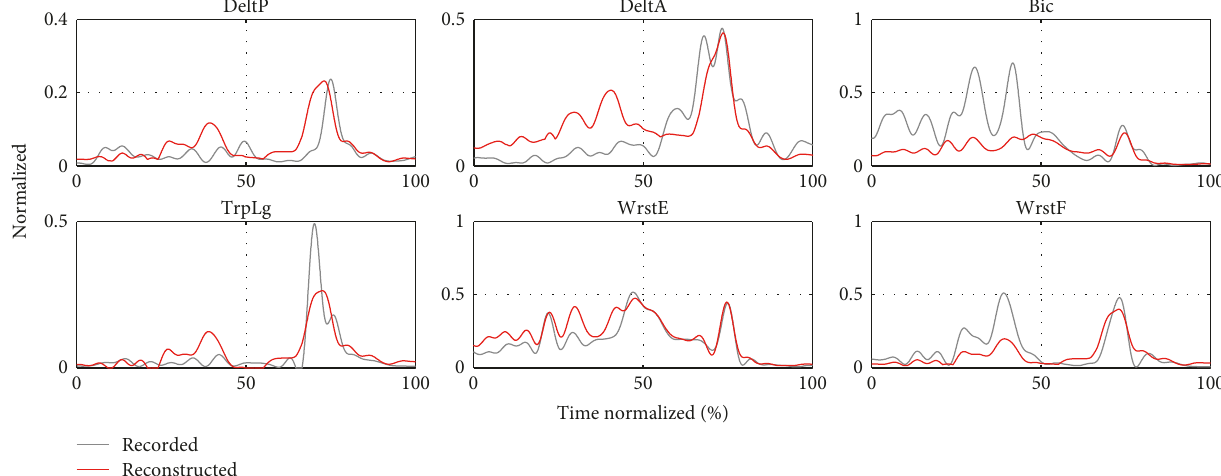
Figure 20: Example 2: activation reconstruction using W